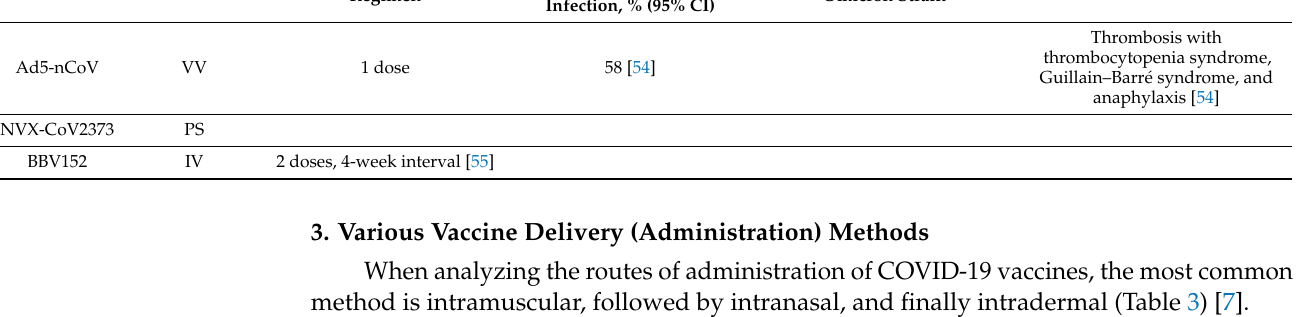
Table 3. Variants of vaccine delivery (administration) methods